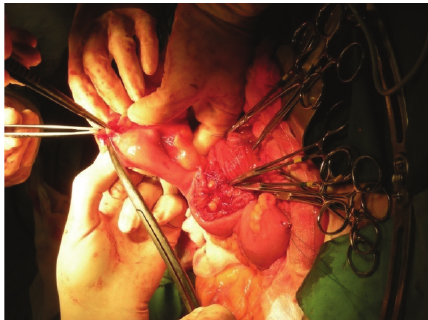
Figure 2: Creation of the pouch with Meckel.